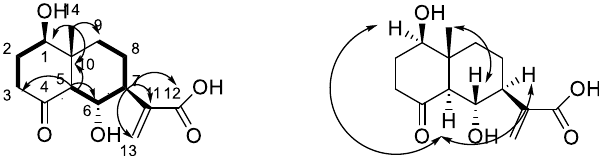
Figure 2. Main 1 H- 1 H COSY (bold lines), HMBC (arrows) and NOE (double arrows) correlations of compound 1 .